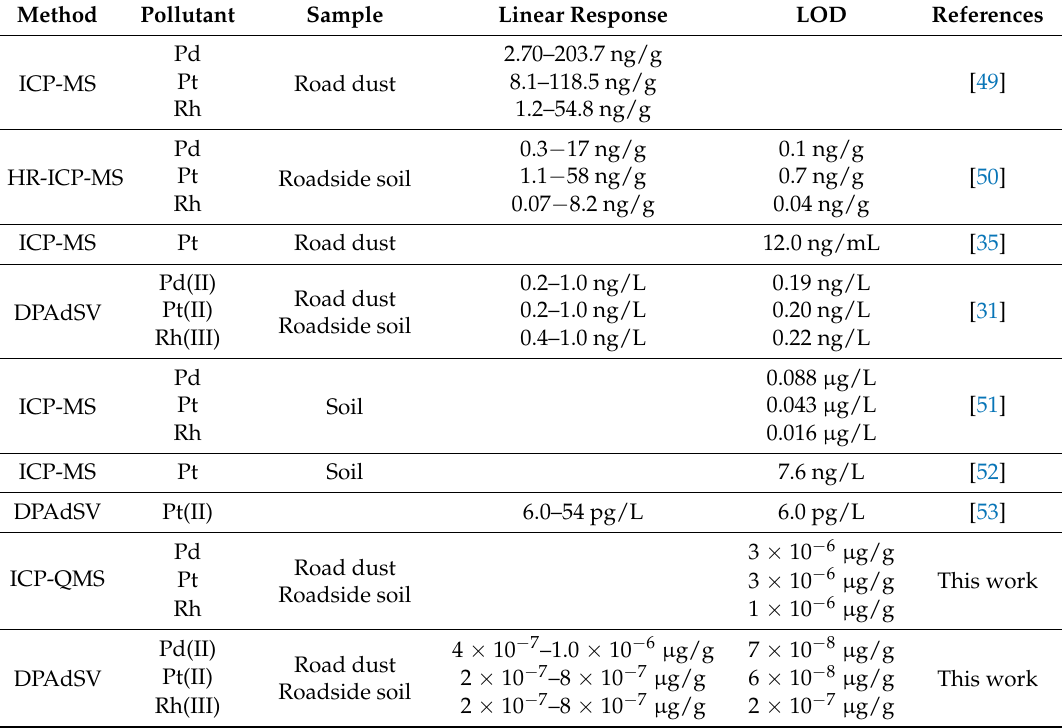
Table 4. Comparison of the limit of detection (LOD) values for the DPAdSV and ICP-QMS results obtained for the determination of Pt, Pd, and Rh concentrations in environmental